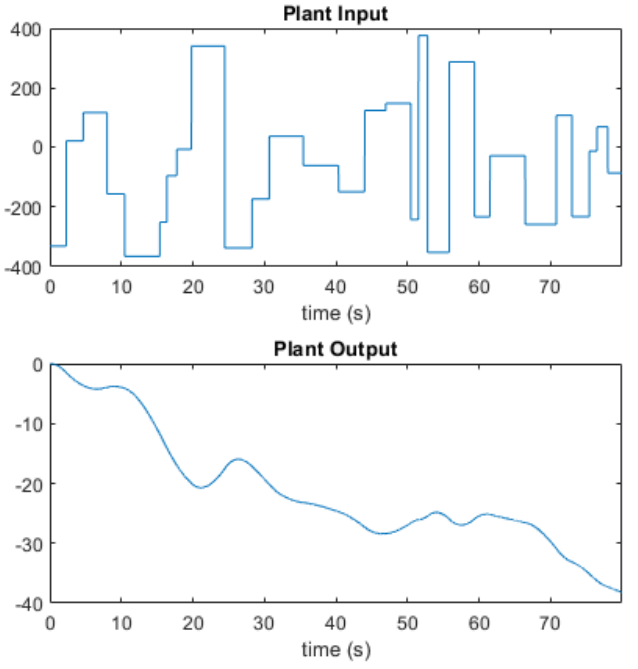
Figure 23. Plant input – plant output neural training data.